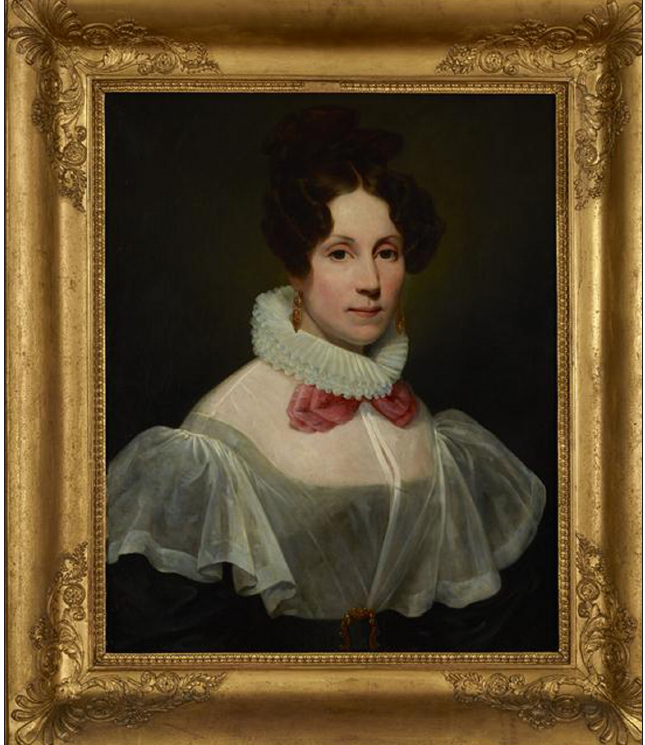
Fig. 7 : Henry Scheffer, Dame en pelisse blanche , undated, oil on canvas, 61 × 50 cm, Rennes, Musée des Beaux-Arts, INV